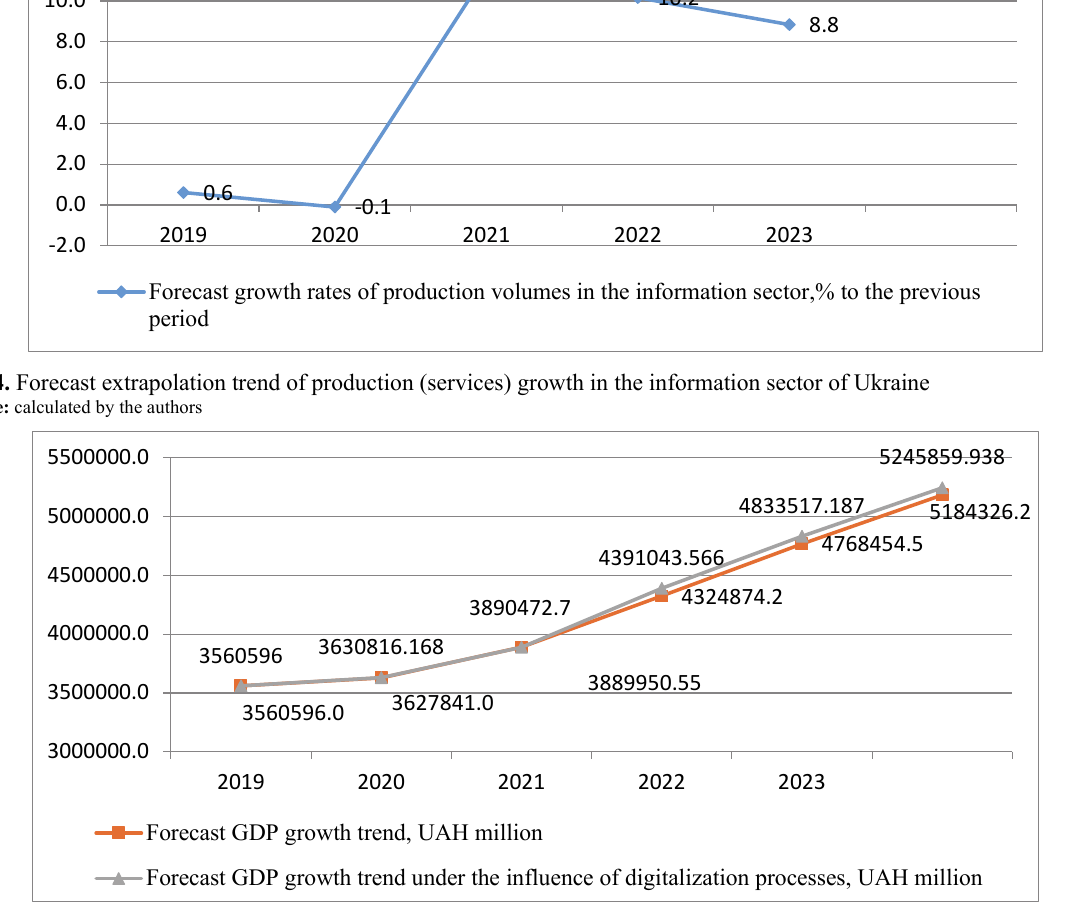
Fig. 5. Forecast of Ukraine's GDP growth taking into account the processes of the economy digitalization in accordance with certain trends Source: calculated by the authors